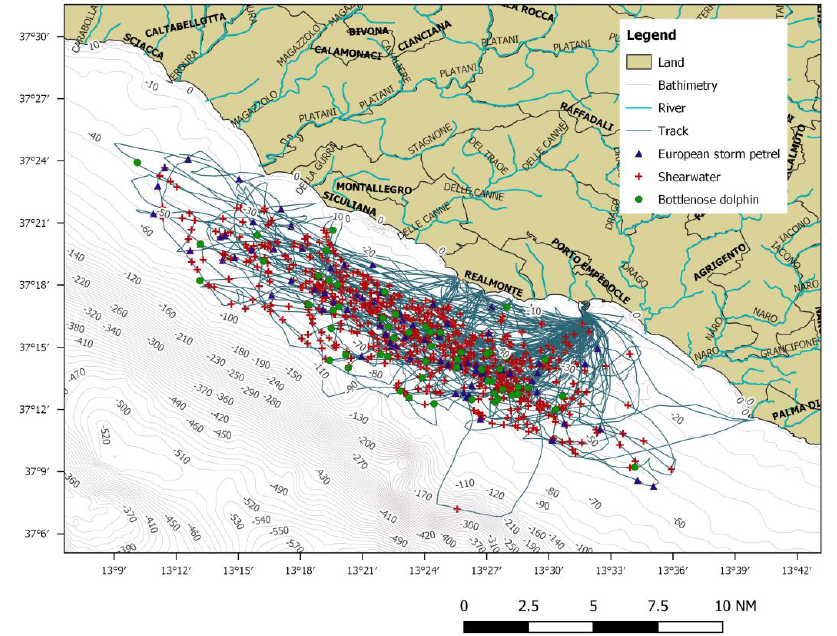
Figure 2. Sightings of bottlenose dolphin (green dots), shearwaters (red crosses), and European storm petrel (blue triangles) in the waters of Agrigento province during the field surveys (tracks in light blue) in the 2018–2019